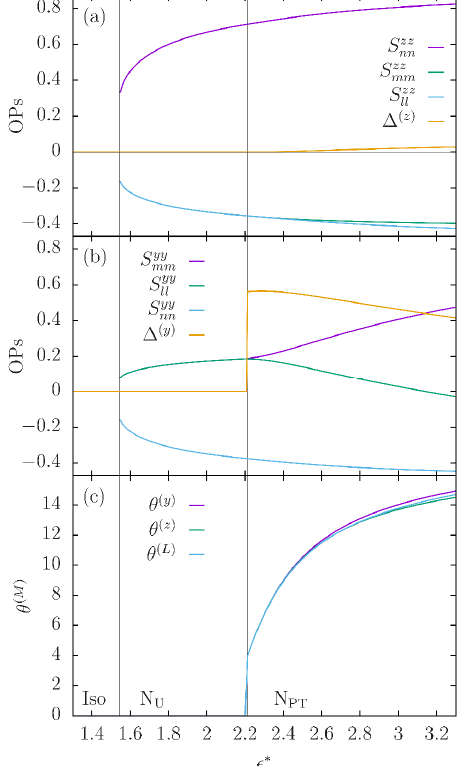
Figure 6. Temperature dependence, calculated from the molecular theory [16] for principal values and rotation angles for the second rank ordering tensors of the C 2 molecular axis y and of the molecular axis z connecting the centers of the mesogenic units of the model dimer molecule (see Figure 4b). The polar director m is, by symmetry, a common principal axis for all the tensors. The other two principal axes, denoted by n ( M ) , l ( M ) , are obtained through a rotation about m by an angle θ ( M ) . The plots are for β = 25 ◦ and α = 30 ◦ . ( a ) The three principal values of the ordering tensor for the molecular axis z . It is seen that the maximal ordering of this axis in the N PT is along a direction, n ( z ) , perpendicular to m. The biaxiality (difference the principal values ∆ ( z ) = S zz mm − S zz ) of the ordering sets in below l ( z ) l ( z ) the transition from the N U and remains relatively small throughout the N PT range. ( b ) Same as in ( a ) for the C 2 axis of the molecule, y . Here, however, the maximal ordering of this axis in the N PT − S yy is along m. Thus the major principal value is S yy mm and the biaxiality ∆ ( y ) = S yy sets in n ( y ) n ( y ) l ( y ) l ( y ) abruptly at the transition and remains large in the N PT . ( c ) Temperature dependence of the rotation angles θ ( M ) , for the molecular segments M = y , z , and L . The differences are not large, but increase with decreasing